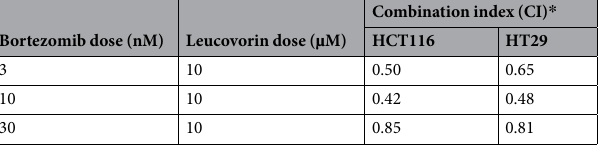
Table 1. Combination index (CI) values for the combination of bortezomib and leucovorin for HCT116 and HT29 cells. * CI > 1, Antagonism; CI < 1, Synergy.